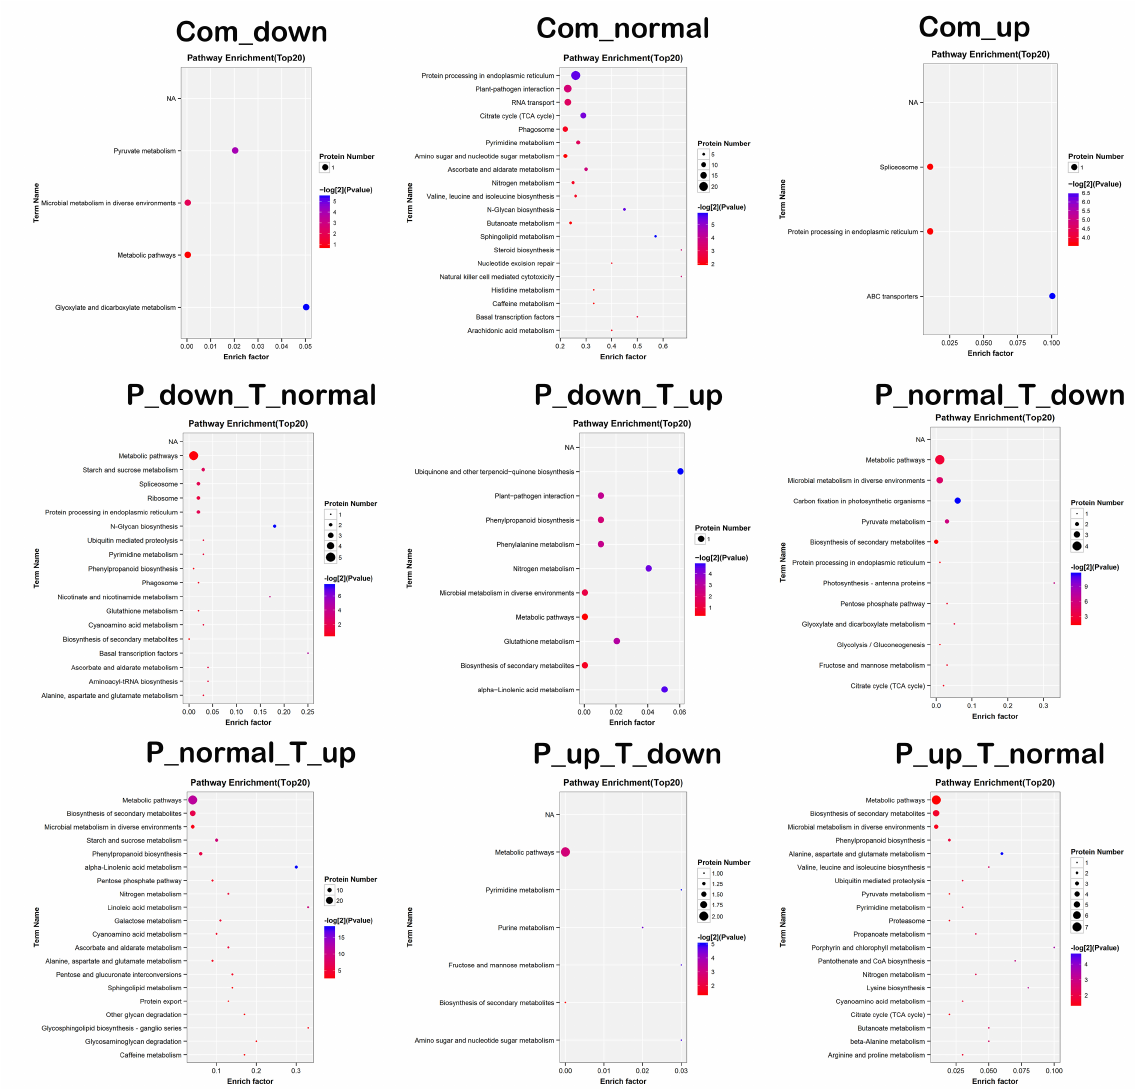
Figure 5. Correlation analysis of KEGG pathway enrichment bubble diagram. X axis for the enrichment factor; Y axis for KEGG pathway. The size of the bubbles represents the number of proteins on the annotated KEGG pathway; the color represents enrichment − log 2 ( p value). A higher value indicates a higher